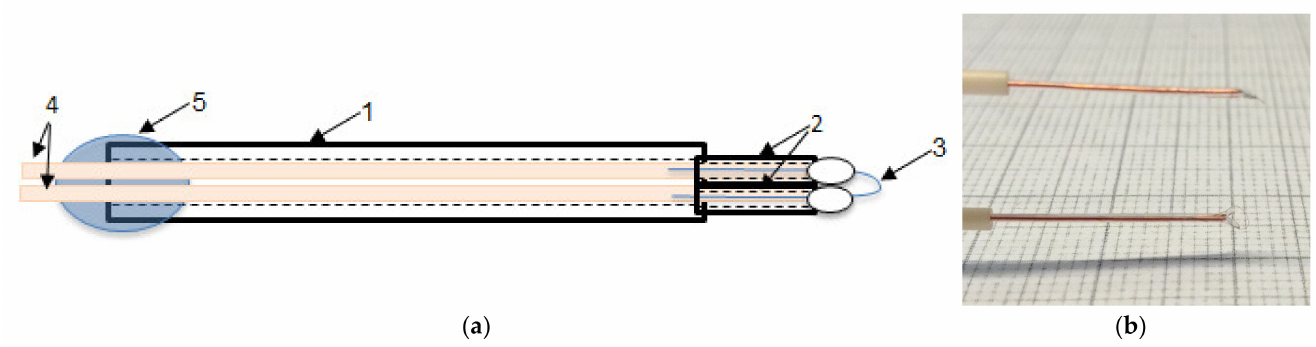
Figure 5. ( b ) Photo of the set of two emissive probes and ( a ) structure of the single emissive probe: 1—Al 2 O 3 tube with outer diameter (OD) 1.6 mm, inner diameter (ID) 1.0 mm; 2—capillary glass tubes OD 0.5 mm, ID 0.3 mm, melted tips of glass capillary are indicated by white ellipses; 3—tungsten wire, diameter 25 µ m; 4—enameled copper wire, diameter 0.3 mm; 5—fixing glue for copper